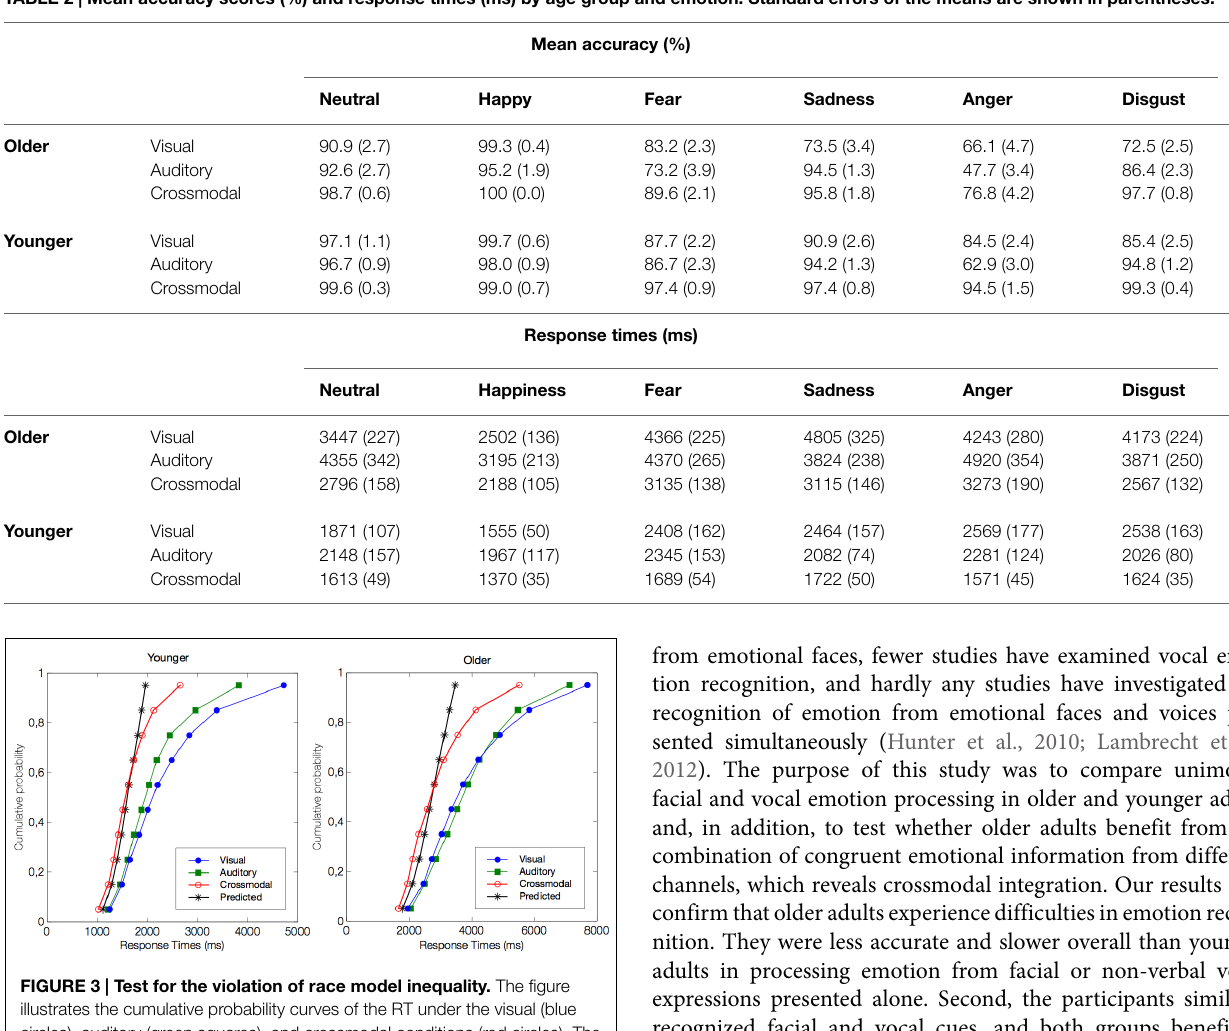
TABLE 2 | Mean accuracy scores (%) and response times (ms) by age group and emotion. Standard errors of the means are shown in parentheses.